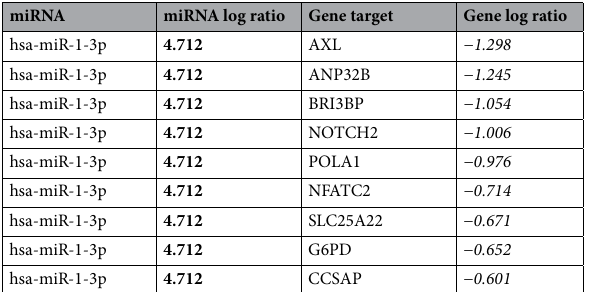
Table 1. Conversely regulated miRNAs and their mRNA targets identified using the miRNA Target Filter Analysis in IPA. For each dose-time-point combination inversely regulated miRNA-mRNA target pairs were identified in miRNA Target Filter analysis based on experimentally validated miRNA-mRNA interactions from mirTarBase and high-confidence predicted interactions from TargetScan. Bold indicate fold change ≥ 1.5 while italics indicate fold change ≤ 1.5. Only pairs with inverse fold change values were